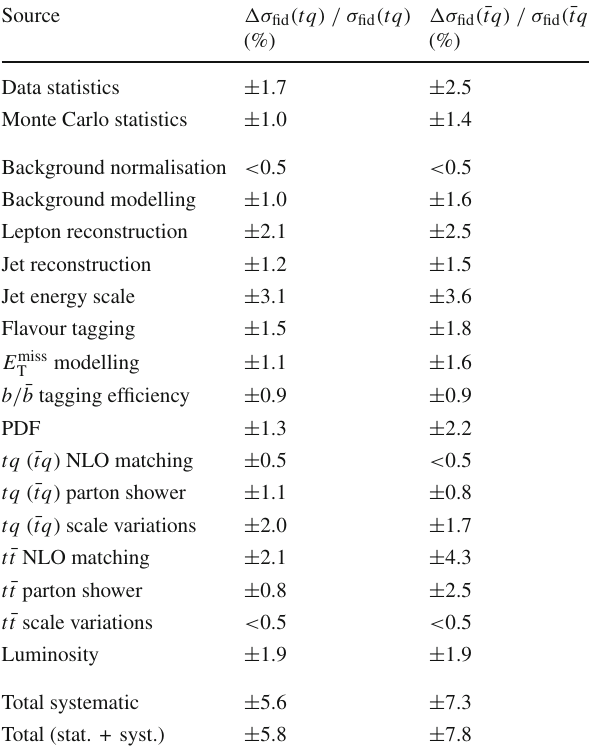
Table 4 Detailed list of the contribution from each source of uncer- tainty to the total uncertainty in the measured values of σ fid ( tq ) and σ ( ¯ tq ) . The estimation of the systematic uncertainties has a statisti- fid cal uncertainty of 0.3%. Uncertainties contributing less than 0.5% are marked with ‘ < 0 .